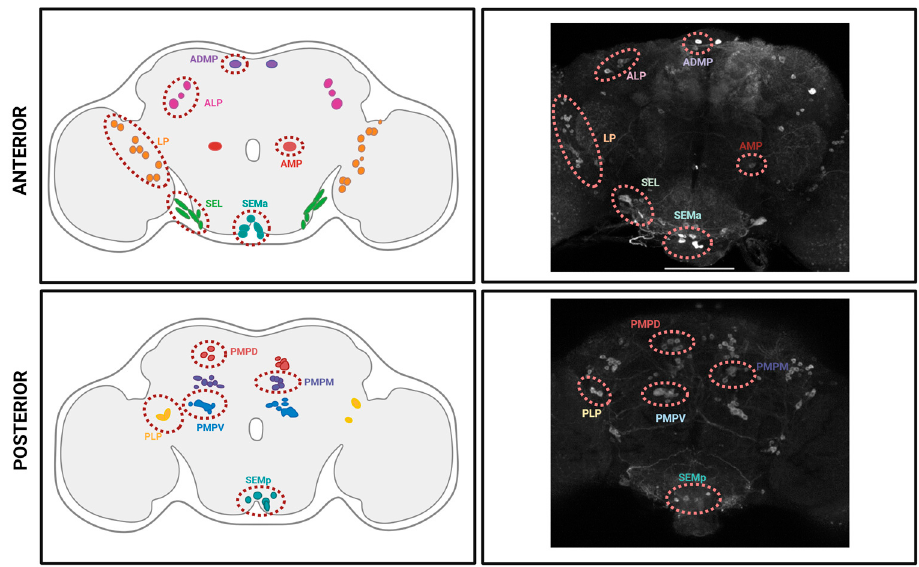
Figure 2. Distribution of serotonergic neuronal populations in the adult fly brain. Left panels, schematic illustration of the anterior (top) and posterior (bottom) halves of the adult fly brain, where eleven clusters of serotonin-releasing neurons are identified in red dashed circles, as it follows: ALP, anterior lateral protocerebrum (pink somas); AMP, anterior medial protocerebrum (red somas); ADMP, anterior dorsomedial protocerebrum (in purple); LP (LP2), lateral protocerebrum (orange somas); SEL (SE1–SE2), lateral subesophageal ganglion (green somas); SEM (SE3), medial subesophageal ganglion, which is subdivided in anterior (SEMa, dark cyan somas) and posterior (SEMp, cyan somas) subclusters; PLP, posterior lateral protocerebrum (yellow somas); PMPD, posterior medial protocerebrum, dorsal (light red somas); PMPM, posterior medial protocerebrum, medial (dark purple somas); PMPV, posterior medial protocerebrum, ventral (light blue somas). Schemes are drawn from data and description in [12,58]. Right panels , representative images of Trh+-immunoreactive neurons in anterior and posterior halves of a Drosophila brain. The serotoninergic clusters are identified in light red dashed circles, and cluster names are indicated. Scale bar: 100 µ m. Reprinted from